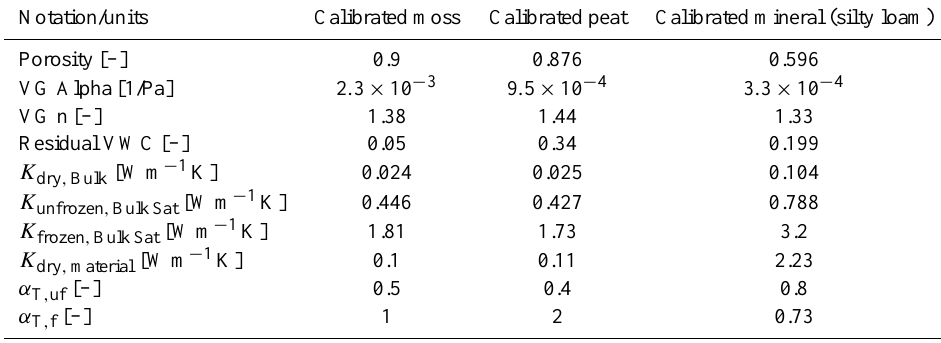
Table 5. Final calibrated parameter table (referred to throughout the